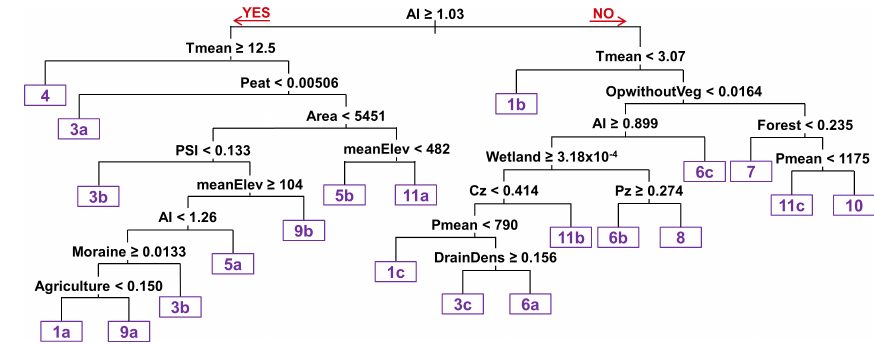
Figure 6. CART tree adjusted on the FS classification and used as a predictive tree for the CART classification.